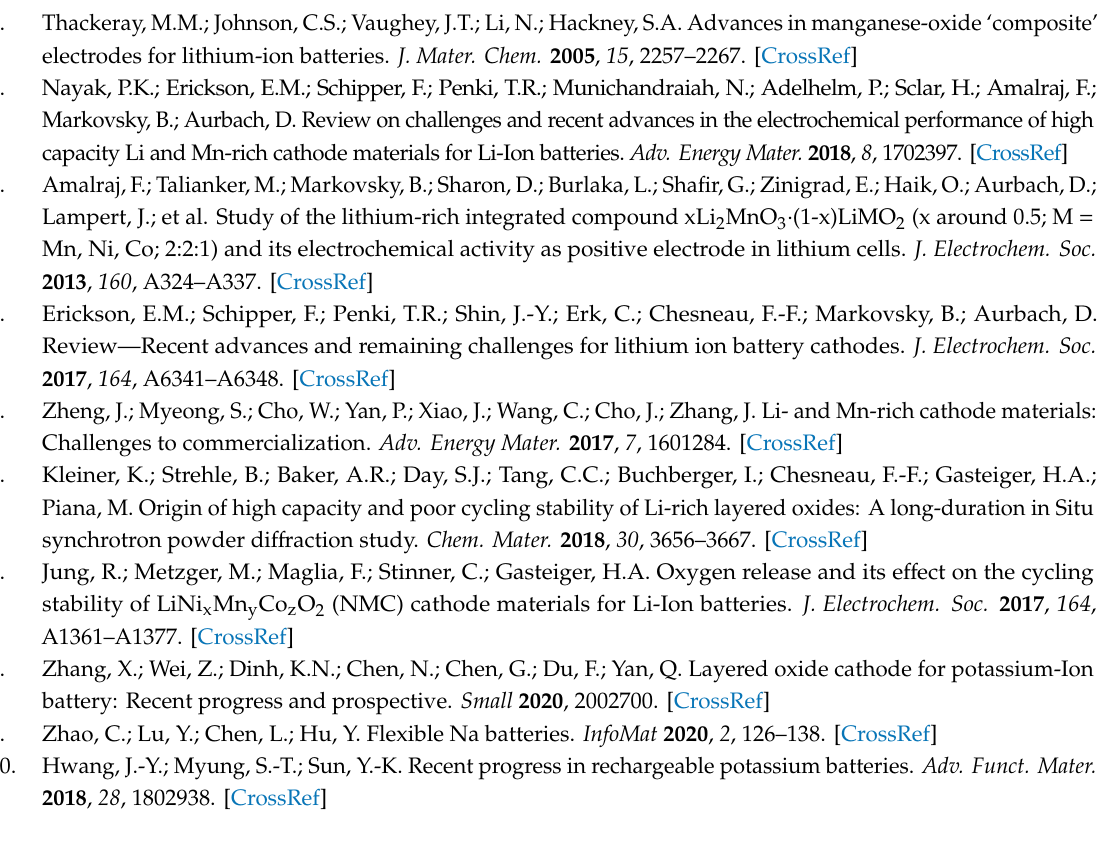
CBED pattern in Figure 7a. Figure S9. Mn K-edge Fourier transform magnitudes of k 3 -weighted EXAFS data and theoretical fits of Li 2 MnO 3 materials: pristine powder (a) and electrodes after the 1st cycle at 0 ◦ C (b) and at 30 ◦ C (c). Figure S10. Mn 2p and Mn 3s XPS spectra, (a) and (b), respectively measured from uncycled (pristine) Li 2 MnO 3 electrode (red lines) and those subjected to the first charge-discharge cycles at 0 ◦ C and 30 ◦ C (green and blue lines, respectively). The Mn 3s spectra include color-coded values for the magnitude of the splitting ∆ , eV between the two peaks. Voltage profiles of these Li 2 MnO 3 electrodes are shown in Figure 2a,b. Table S1. Cell parameters of Li 2 MnO 3 materials calculated from the corresponding XRD patterns. Table S2. Results of XPS measurements of the lattice oxygen in Li 2 MnO 3 , per-oxo like and other components as calculated by fitting of the corresponding O 1s spectra measured from pristine (uncycled) Li 2 MnO 3 electrode and those after initial activation cycles at 0 ◦ and 30 ◦ C. The corresponding binding energies (in eV) are shown in blue color. Table S3. Best fit results for the structural parameters obtained by analysis of the Mn K-edge EXAFS data of Li 2 MnO 3 samples: pristine powder and electrodes after the 1st cycle (charge to 4.7 V, discharge to 2.0 V) at 0 ◦ and 30 ◦ C. N: coordination number; R: interatomic distance; σ 2 : Debye-Waller factor (mean-square disorder in R); ∆ E o : Energy shift; (amp): the amplitude reduction